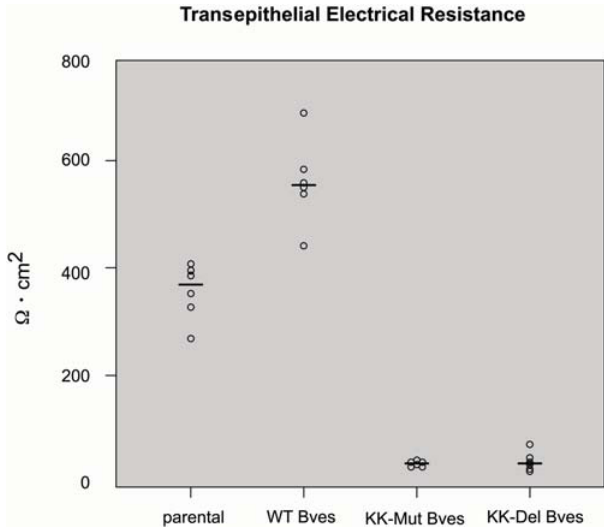
Figure 8. Measuring of transepithelial electrical resistance in HCE cells. Parental cells and cells expressing transfected WT Bves, KK- Mut Bves and KK-Del Bves were grown to confluence and assayed for transepithelial electrical resistance (TER) using EVOM volt-ohm-meter. Expression of transfected WT Bves increases TER. Conversely, cells expressing KK-Mut Bves or KK-Del Bves have TER values approaching